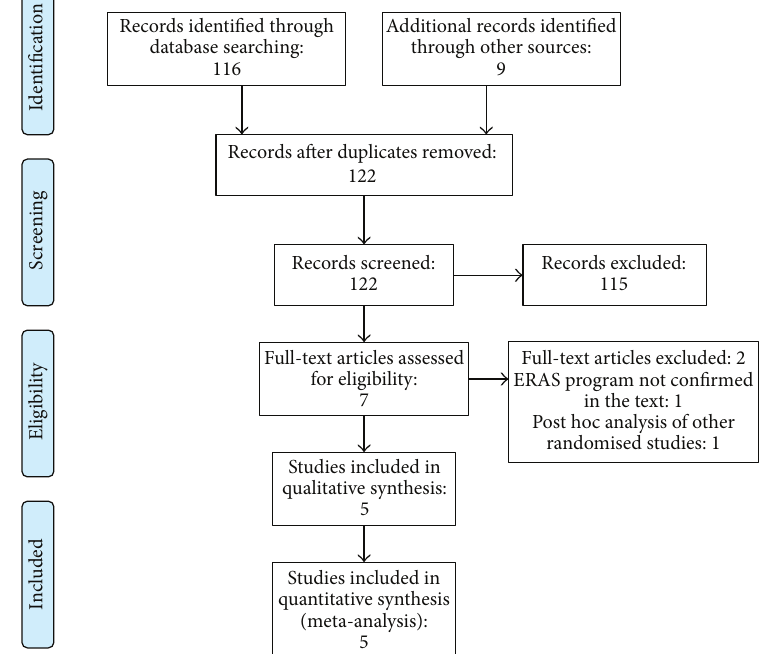
Figure 1: PRISMA diagram of study selection.